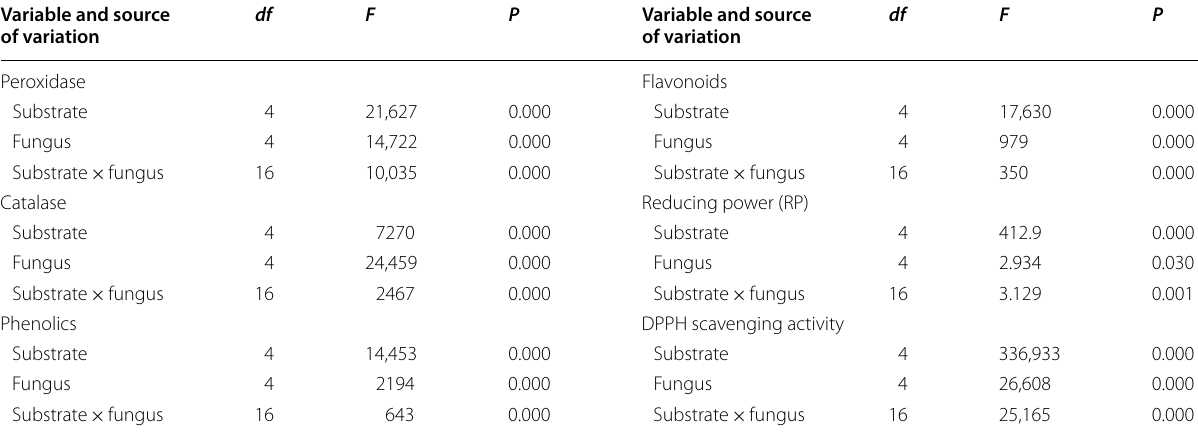
Table 1 Two-way ANOVA showing the effect of the main factors (type of substrate and fungus) and their interaction on the antioxidant activity of the SSFS Variable and source of variation